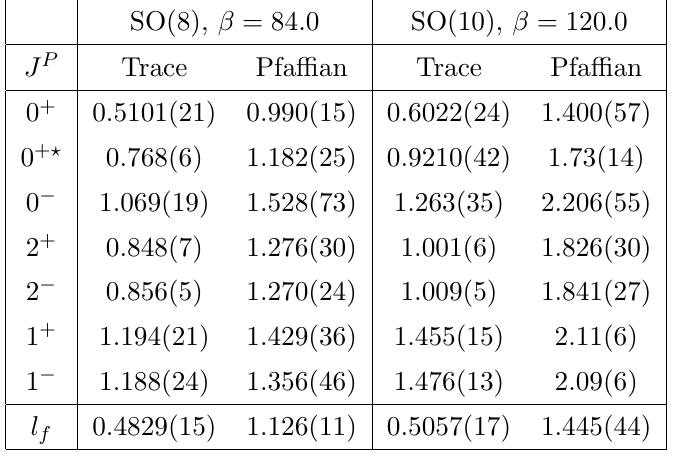
Table 6 . Lightest glueball masses in SO(8) on a 28 2 36 lattice and in SO(10) on a 22 2 30 lattice at the couplings shown for various spins J and parity P . Also shown is the energy of the lightest (cid:13)ux loop, l f , winding around a periodic spatial